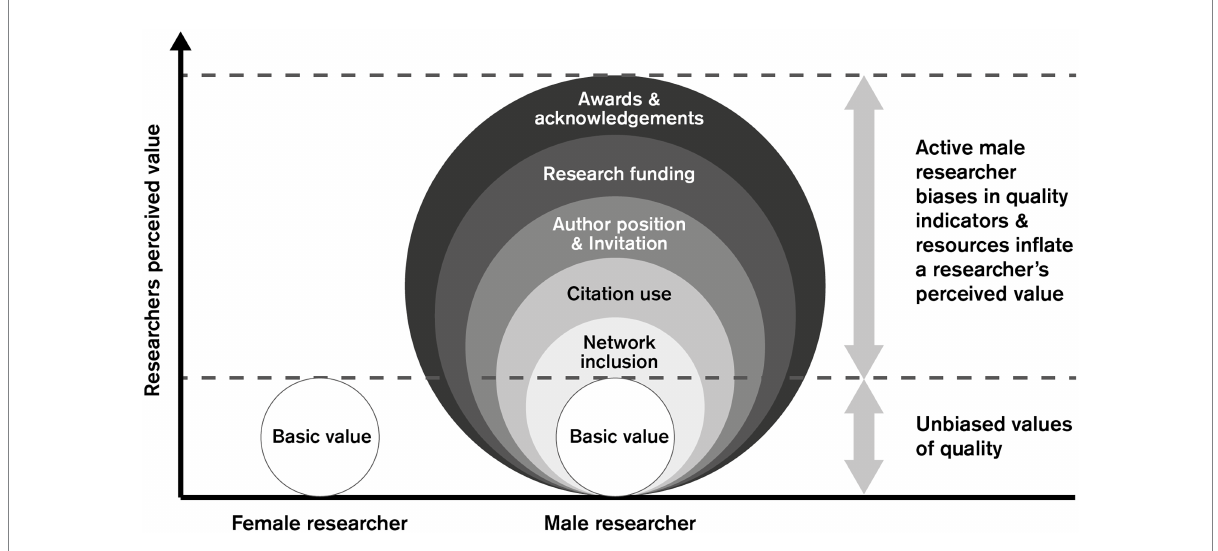
FIGURE 1 Schematic figure describing known and current factors that inflate male researchers’ perceived value (e.g., Dolphin, 2006; West et al., 2013; Cameron et al., 2016; Van den Besselaar and Sandström, 2017; Salerno et al., 2019; Dworkin et al.,